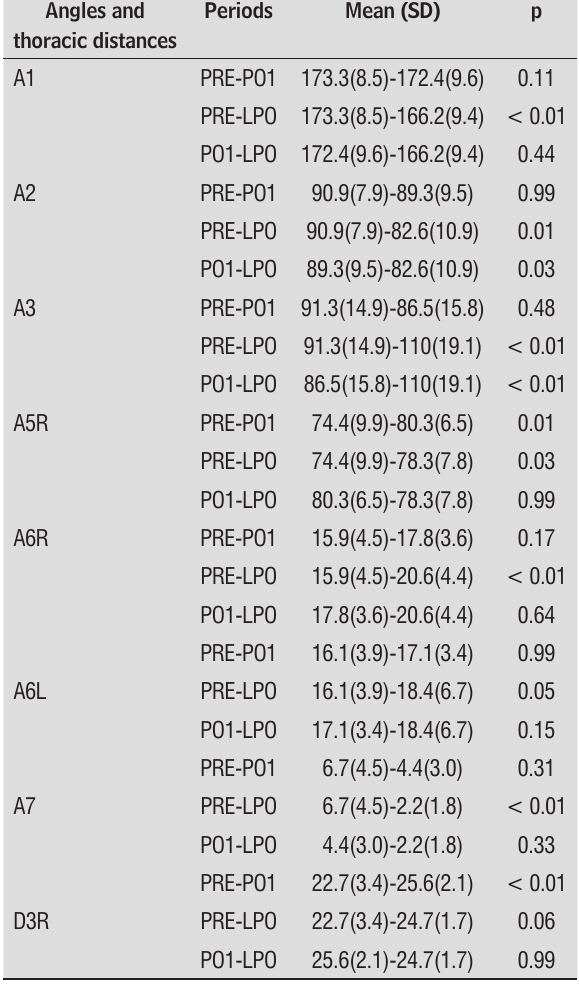
Table 2 - Comparison of the values of the domains and total score of the SRS-30 quality of life questionnaire in the Preoperative (PRE), Postoperative (PO1) and late Postoperative (LPO) periods of the